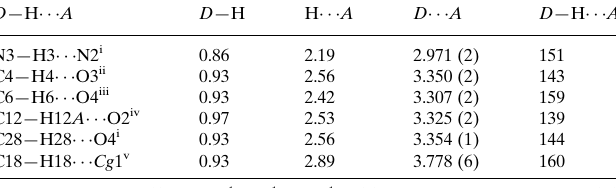
Hydrogen-bond geometry (A ˚ , (cid:2) ). Cg 1 is the centroid of the C3–C8